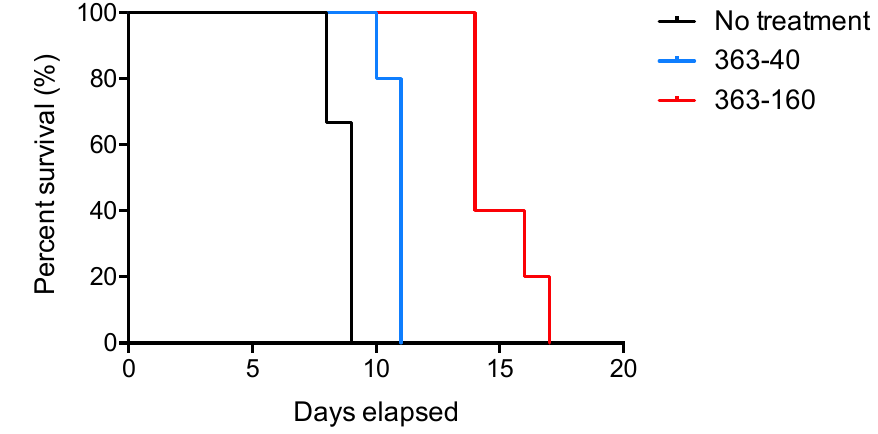
Figure 3. Survival curves of mice following acute toxoplasmosis. CD1 mice ( n = 18) were infected with 100 RH tachyzoites and treated with JF363 at 40 mg/kg ( n = 6) (363-40) or 160 mg/kg ( n = 6) (363-160) or with PBS as a control (no treatment, n = 6) by oral route. 2.2.2. Effect of the JF363 on Cyst Formation in Chronically Infected Mice To assess the efficacy of compound JF363 on Toxoplasma cyst formation, infected CBA mice were treated for 15 days, two months post-infection. Then, 15 days later, mice were sacrificed, and brain cysts were counted. Many cysts (168 ± 95, range 76 to 312) were detected in the infected nontreated mice, whereas in infected mice treated with the compound JF363 (40 mg/kg), a significantly ( p < 0.05) lower number of cysts (57 ± 29; range 21–85) was detected (Figure 4). Thus, the JF363 significantly decreases the number of cysts in the brain of infected mice. ` Figure 4. Cyst burden in infected mice. CBA mice were infected with 500 tachyzoites of type II Prugniaud strain. After 2 months, animals were not treated ( n = 5) or treated with the JF363 drug at 20 mg/kg ( n = 2) (363-20) or 40 mg/kg ( n = 4) (363-40), via oral delivery. Cysts were counted 15 days later. Values were submitted to the Mann–Whitney test (* p < 0.05).